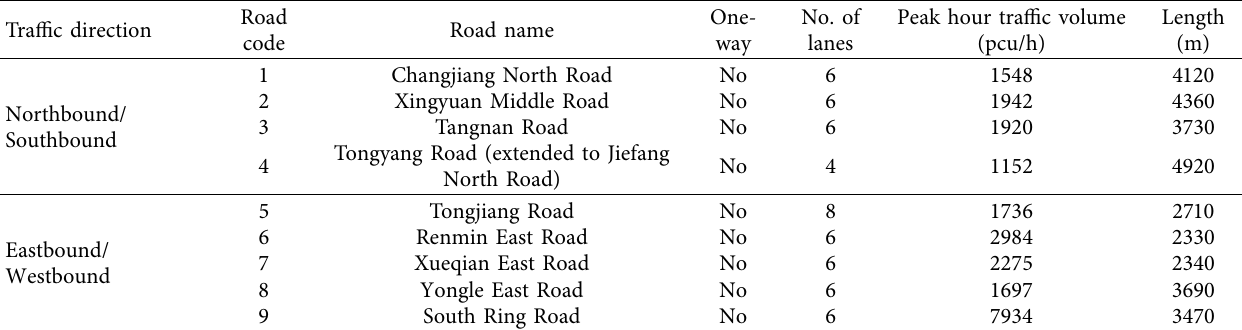
Table 6: Traffic information of the selected